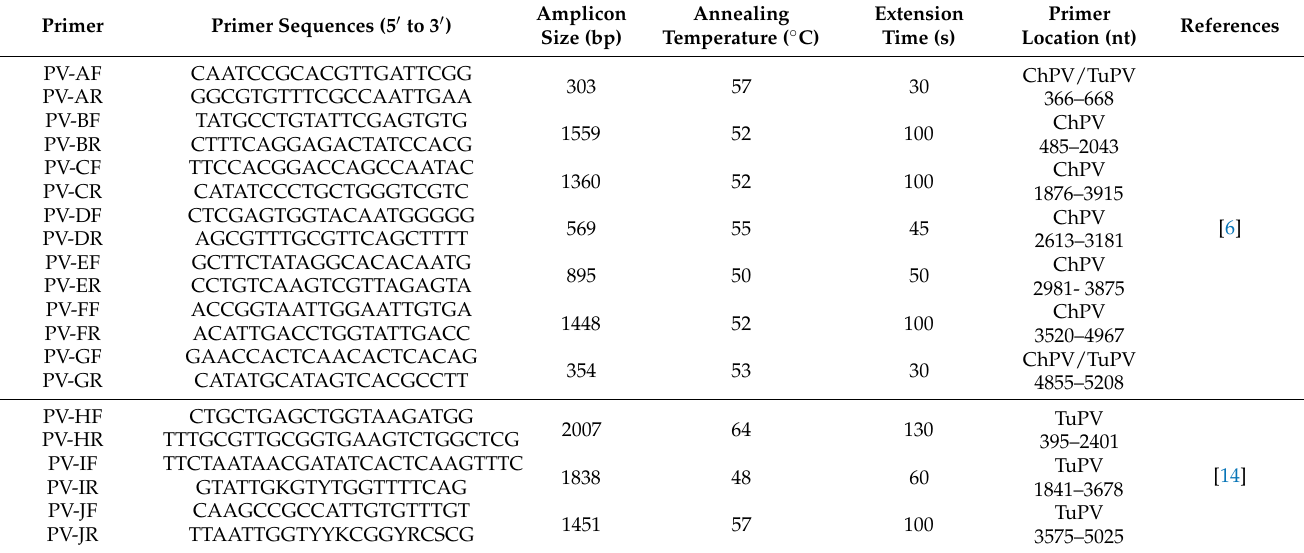
Table 2. Primers used in this study for polymerase chain reaction amplification of the complete genome of chicken parvovirus (ChPV) and turkey parvovirus (TuPV).